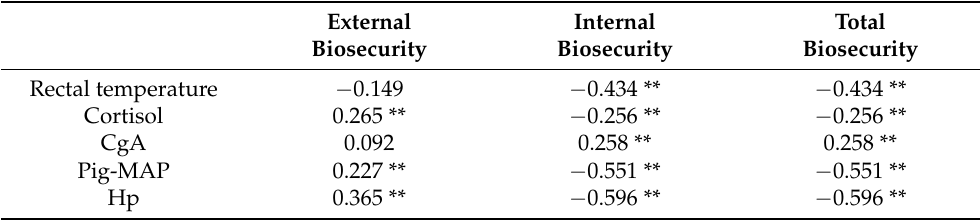
Table 2. Partial Spearman correlations (rs) between farms’ biosecurity measures, mean rectal temper- ature, stress and acute-phase proteins plasma levels (log 10 ) at four farms.